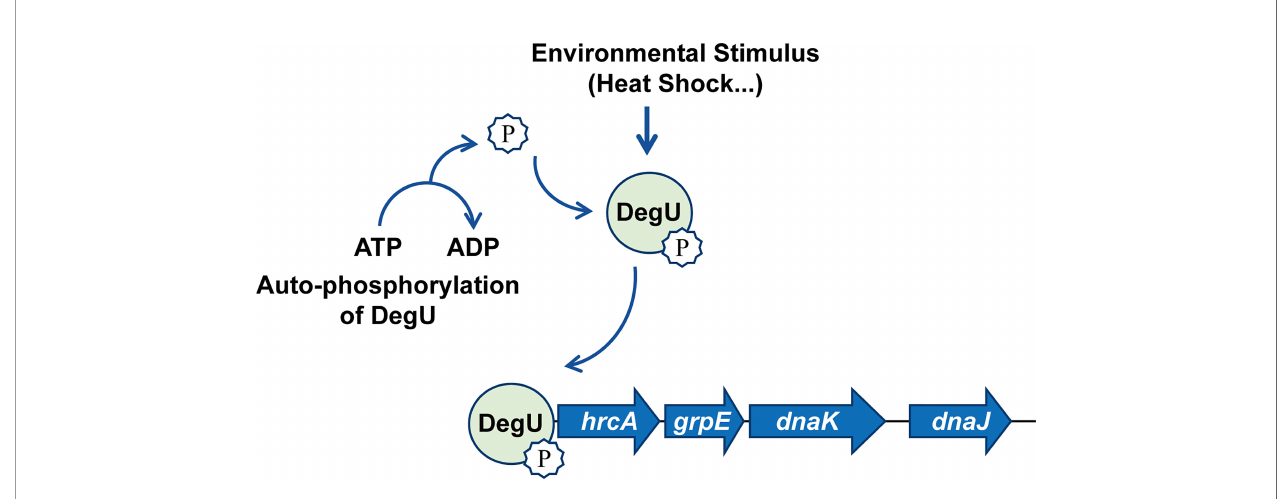
FIGURE 5 | Model illustrating that DegU mediates heat resistance in Listeria monocytogenes . Under heat stress, DegU responds by undergoing autophosphorylation and directly activating the transcription of the hrcA heat-shock